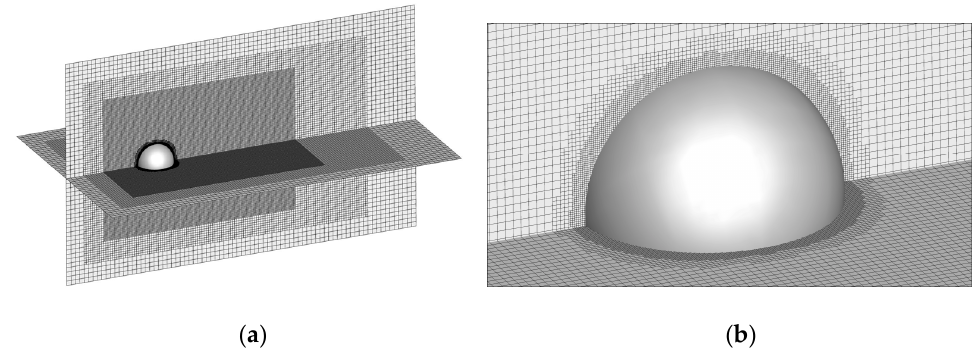
Figure 19. ( a ) shows the multi-layer grid structure of the sphere around the flow in 3D, with the